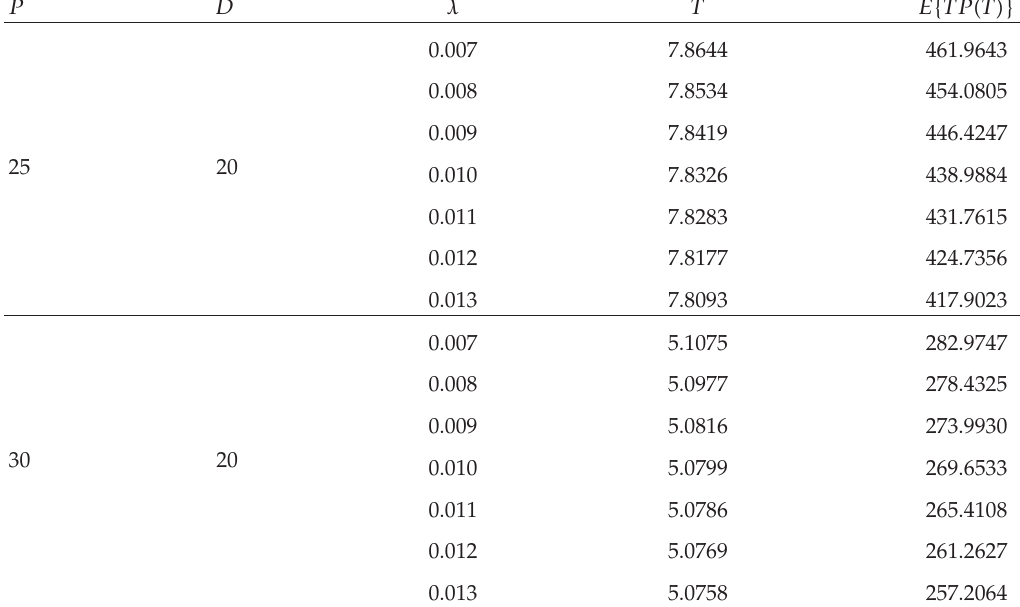
Table 2: Results due to di ff erent λ